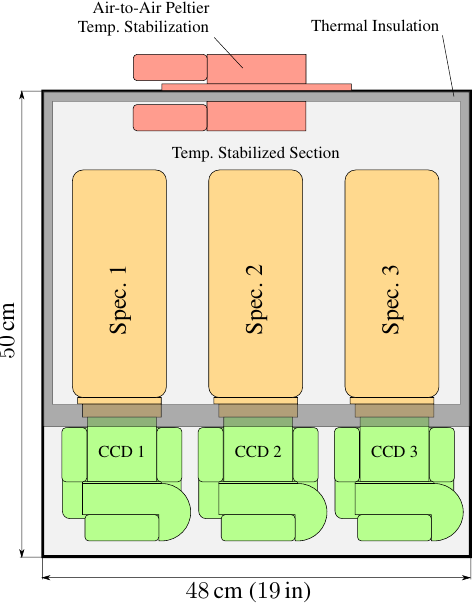
Figure 6. Schematic of the HAIDI instrument rack with three spec- trographs and detectors installed. The Air-to-Air Peltier tempera- ture stabilization controls the temperature inside the gray shaded volume. Since the detectors have a separate cooling for the CCD, which produces considerable amounts of heat, they are located out- side the temperature stabilized section.